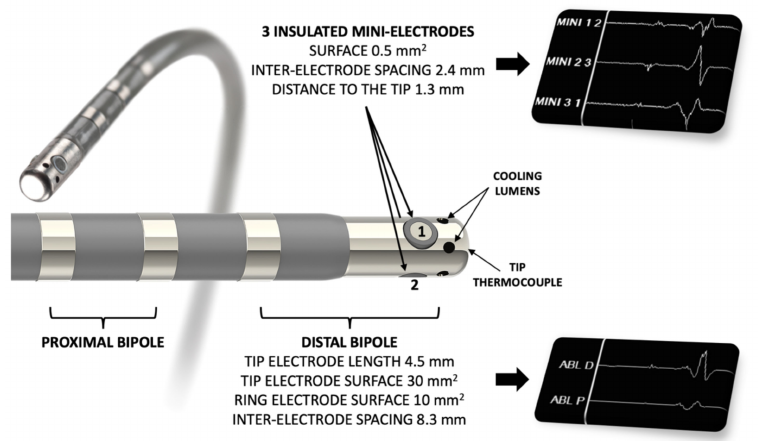
Figure 1. Catheter used for mapping and radiofrequency ablation (IntellaTip Micro Fidelity Open Irrigated MiFi OI, Boston Scientific, Boston, MA, USA). The three insulated mini-electrodes are radially arranged directly on the radiofrequency-delivering 4.5 mm irrigated distal tip. Bipolar recordings are performed between electrodes 1–2, 2–3 and